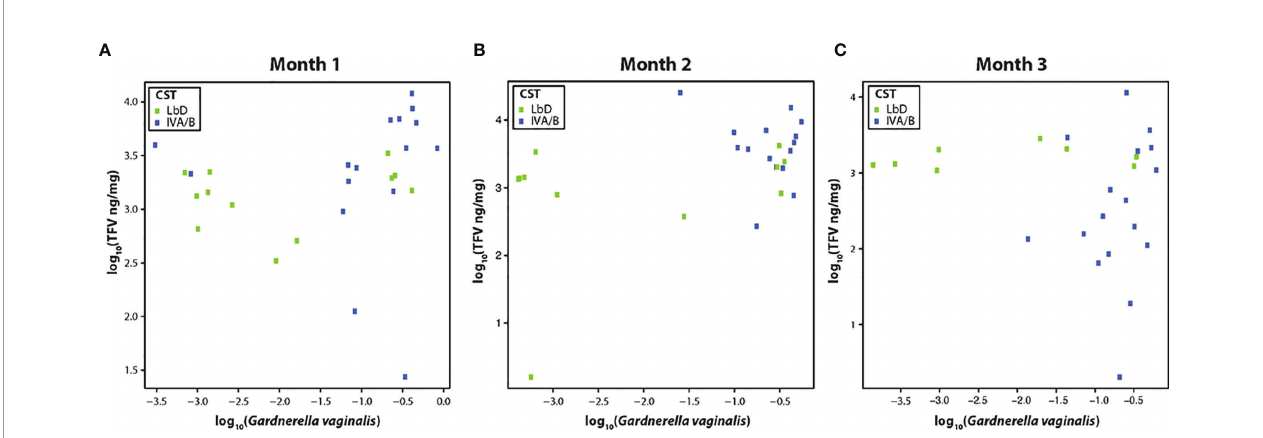
FIGURE 1 | (A – C) Correlation of tenofovir (TFV) vaginal fl uid concentration with the relative abundance of Gardnerella vaginalis at months 1, 2, and 3. Green dots represent participants who had Lactobacillus-dominated (LbD) vaginal microbiota at the time of sampling and their individual TFV vaginal fl uid concentration and